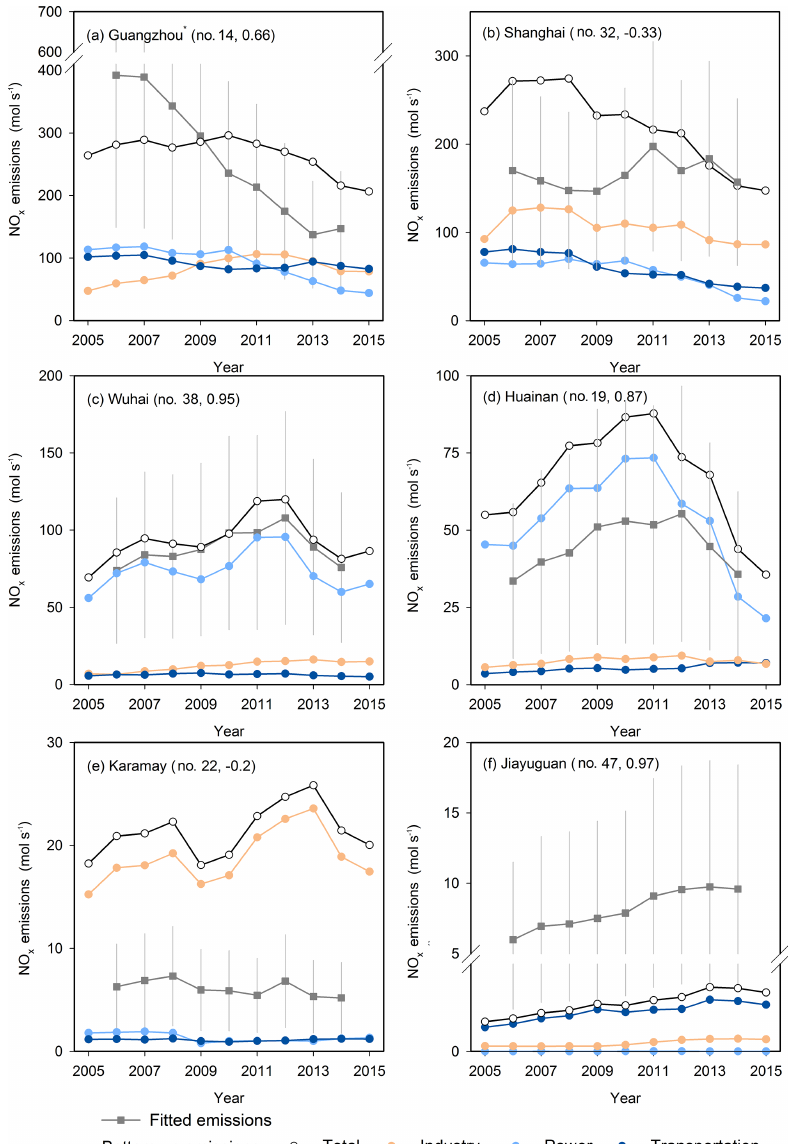
Figure 4. Interannual trends in the fitted (gray squares) and bottom-up anthropogenic NO x emissions for 2005 to 2015 including total (black circles), industrial (pink circles), power plant (light blue circles), and transportation (dark blue circles) emissions. Error bars denote the uncertainty of the fitted NO x emissions. The IDs from Fig. 1 and the correlation coefficients of the pair-wise trends between the bottom-up and fitted NO x emissions are shown in the bracket after the name of the city. Guangzhou ∗ represents the cities of Guangzhou, Foshan, and Dongguan, which are recognized as the same hot spot in the map of NO 2